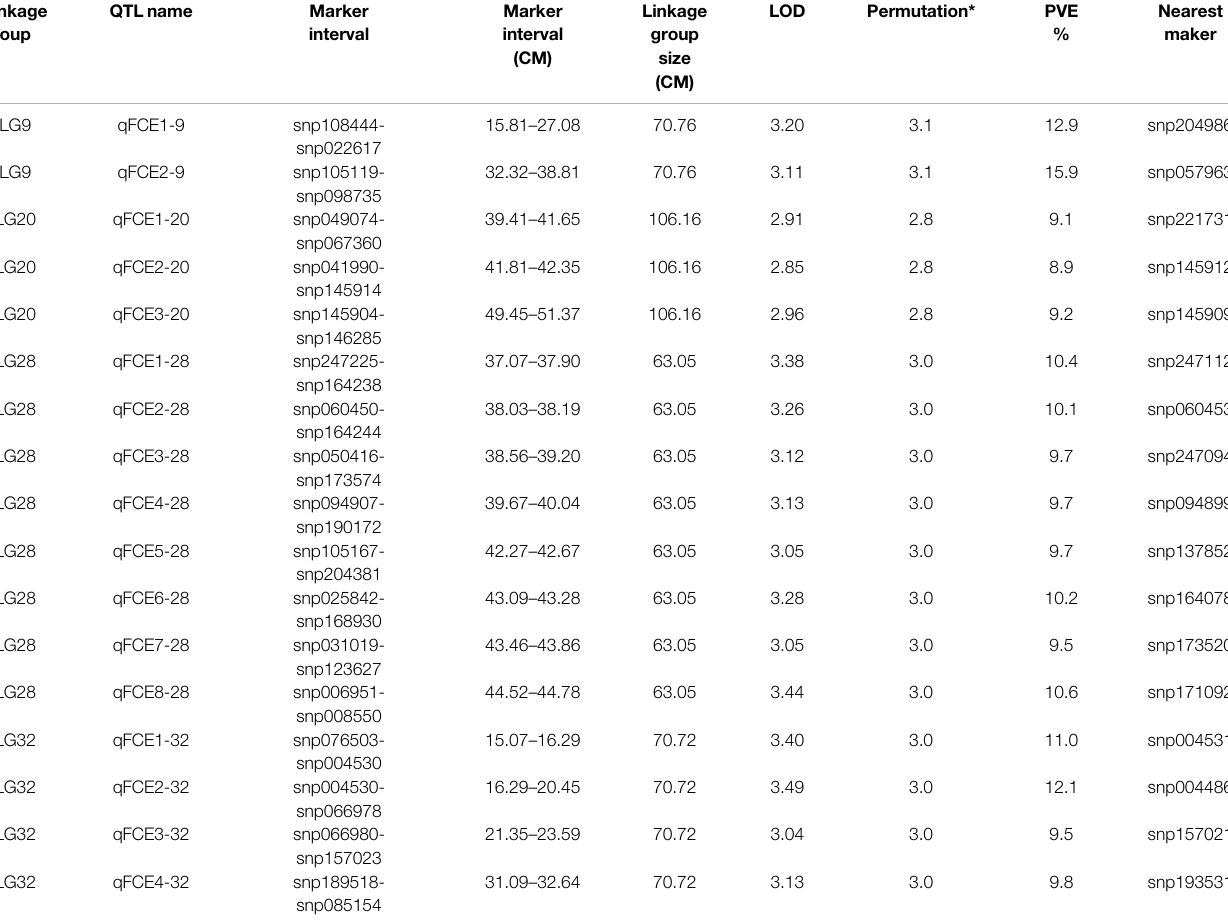
TABLE 4 | Analysis of QTL and estimation of genetic effects.